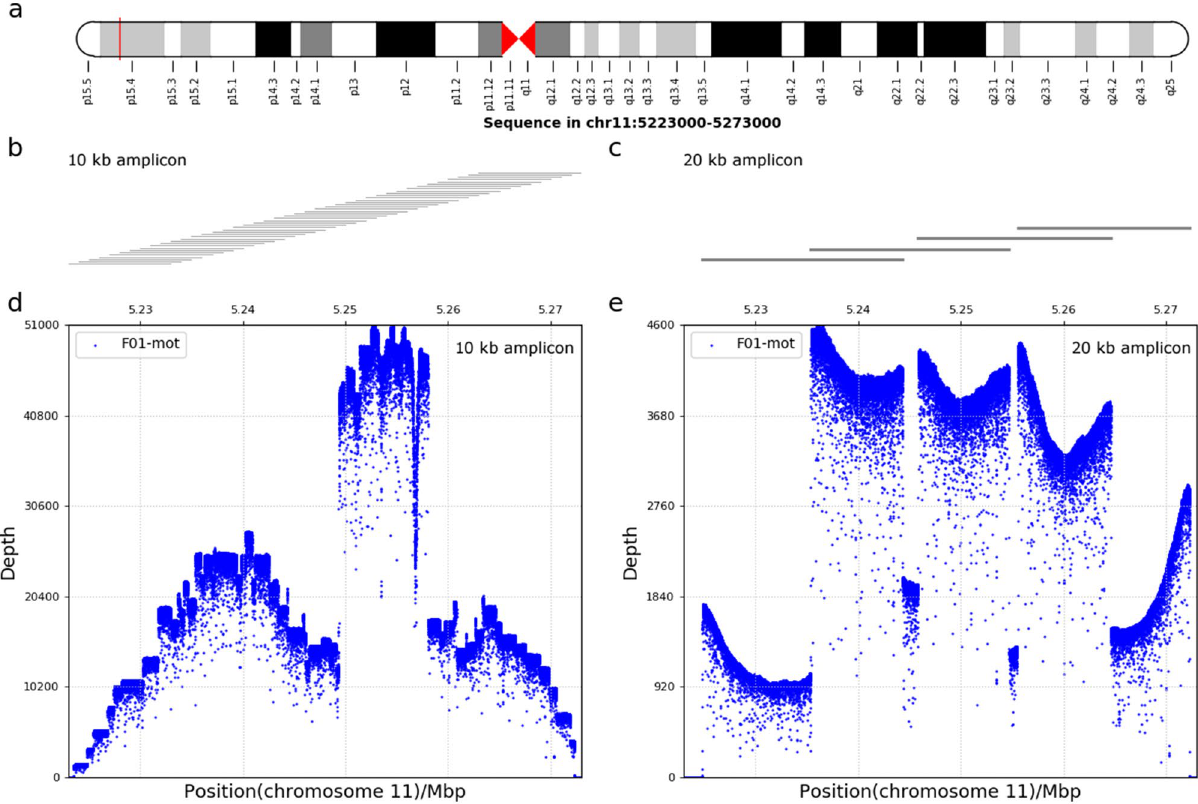
Figure 1. Targeted region of MinION sequencing. ( a ) Diagram of the targeted region locus on chromosome 11 containing the HBB gene selected for this study was indicated by the red vertical line. (b and c) Long-range PCR strategy used for haplotyping. PCR amplicons of 10 kb and 20 kb libraries was indicated in ( b , c ) respectively. 10 kb or 20 kb PCR amplicons were designed overlapped and each horizontal line represents an amplicon. ( d , e ) The depth distribution and the coverage of sequencing data in the whole targeted region. Examples of the depth distribution of targeted region by MinION sequencing for 10 kb and 20 kb libraries was indicated in ( d , e ) respectively. The horizontal axis represents the position on chromosome 11. The vertical axis represents sequencing